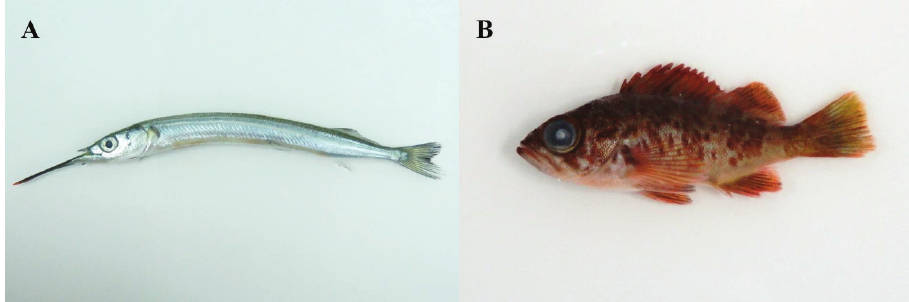
Figure 2. A Hyporhamphus sajori , MFD-746, 77.3 mm standard length (SL) B Sebastes inermis , MFD- 902, 47.5 mm SL.